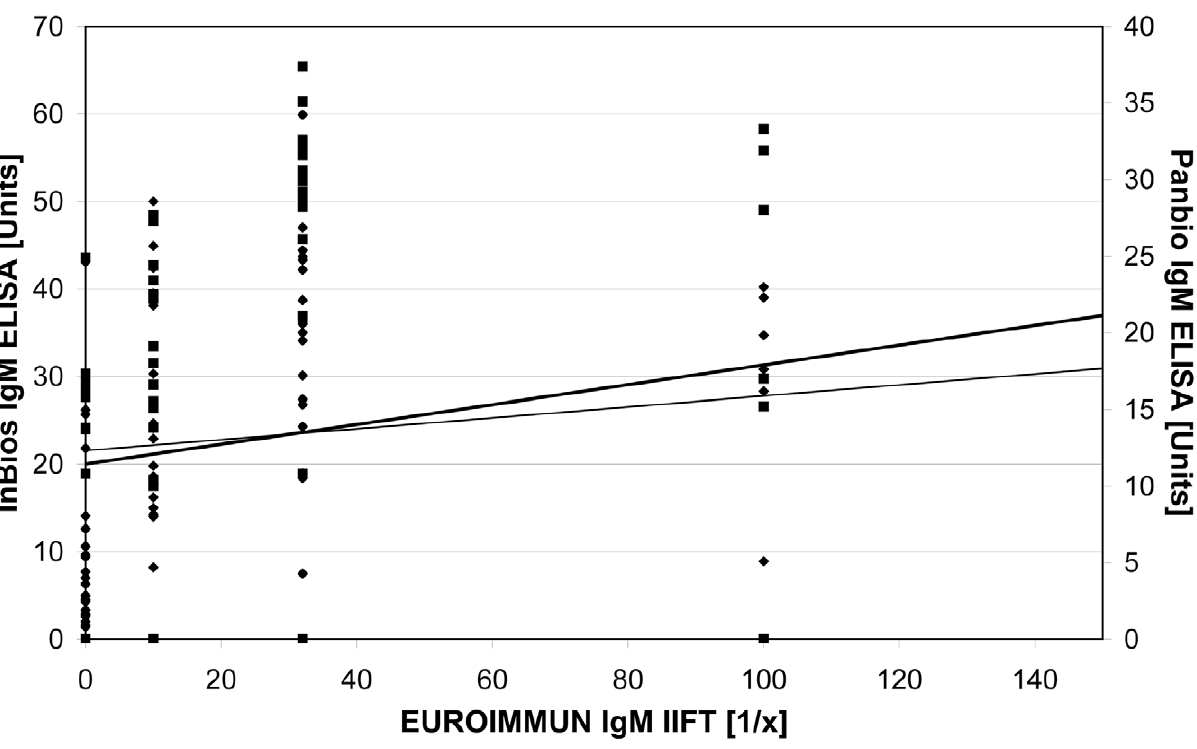
Figure 1. Scatter blot comparing the results of the InBios and the Panbio IgM capture ELISA with the results of the EUROIMMUN IgM IIFT. To facilitate the readability one IIFT outlier (1:320) was taken out of the diagram. Test values: Panbio IgM capture ELISA results ( & ), InBios IgM capture ELISA results ( X ). Trend line: Panbio IgM capture ELISA results (thin), InBios IgM capture ELISA results (thick).